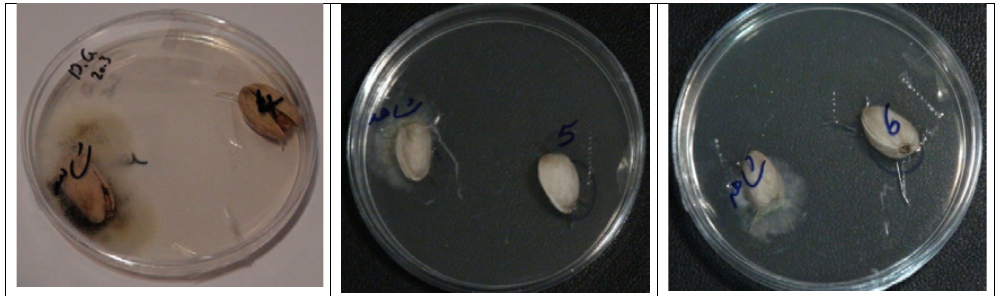
Fig. 5. Antimicrobial activity of coated PLA nano-composites containing ZnO 1%, 3% and 5% (a, b and d) and uncoated pistachios against Aspergillus parasiticus (PTCC 5286)